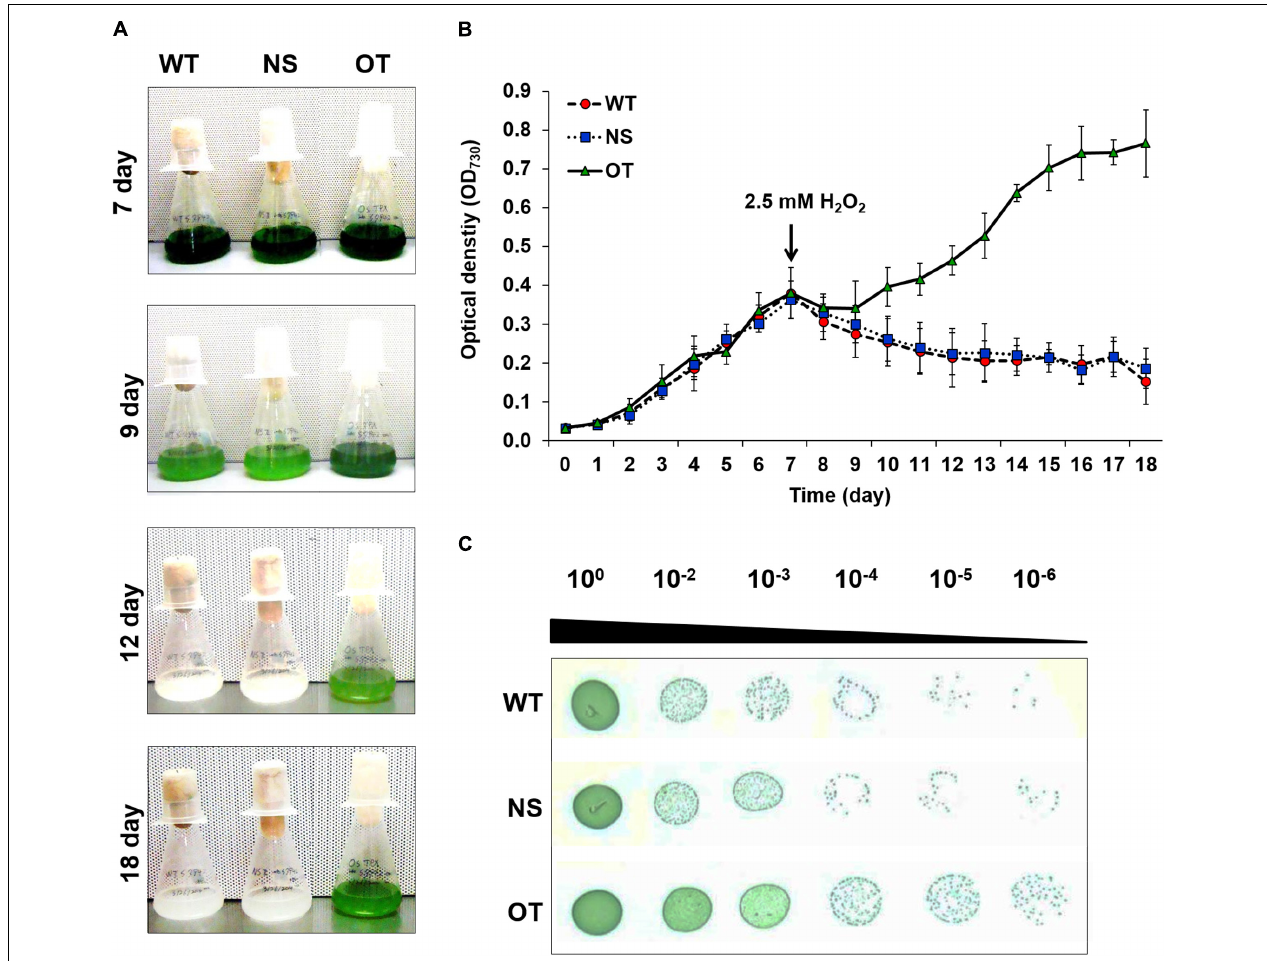
FIGURE 4 | Analysis of WT, NS, and OT strains H 2 O 2 stress tolerance. (A) Phenotypes, (B) growth phase of each strains, and (C) spotting assay and error bars calculated from the SD of three independent experiments. WT, wild-type; NS, empty neutral-site vector strain; OT, overexpression transgenic strain. Error bars indicate ± SD of three independent experiments. Asterisks indicate significant differences between treatments as estimated by Student’s t -test ( P <